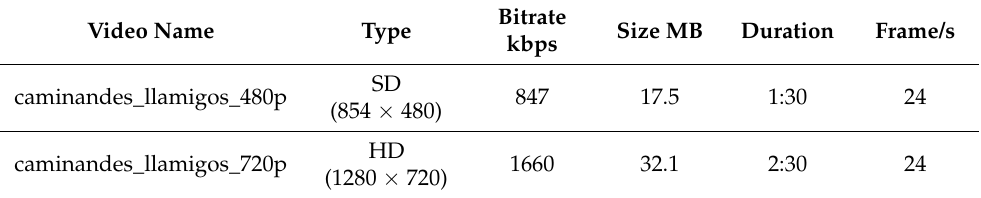
Table 3. Videos’ simulated QoE parameters.